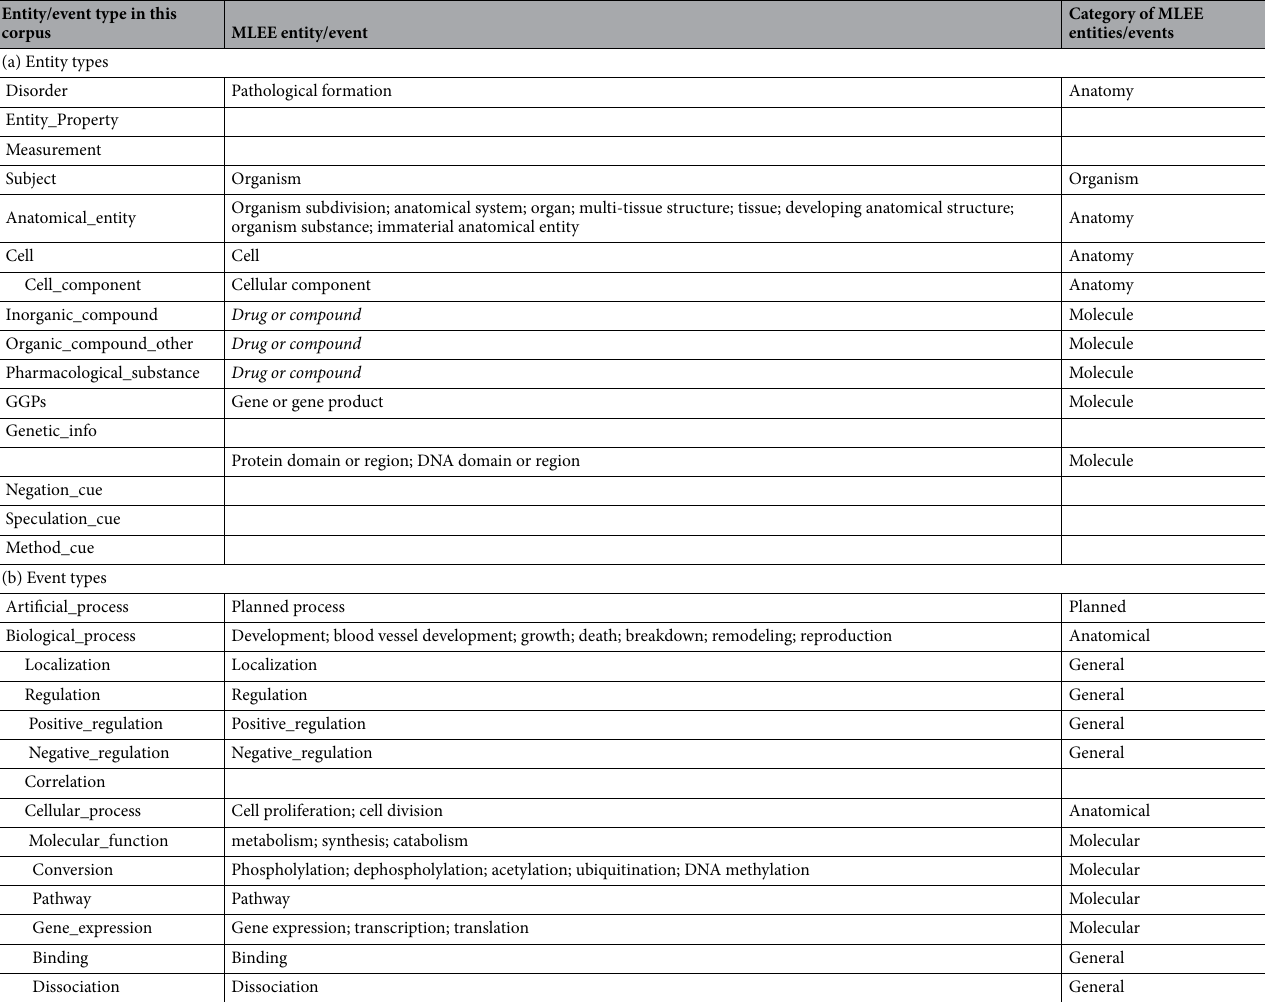
Table 11. Entity/event types in this corpus and those defined in the MLEE